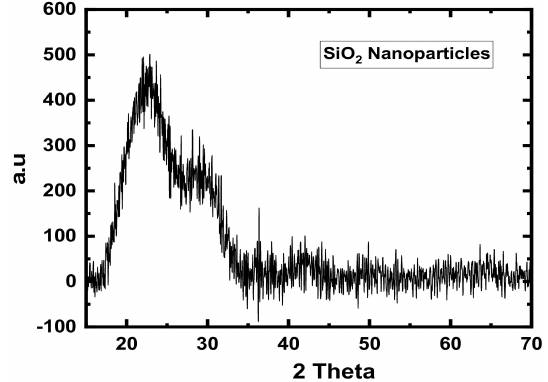
Figure 2. The XRD pattern obtained for the SiO 2 nanoparticles.